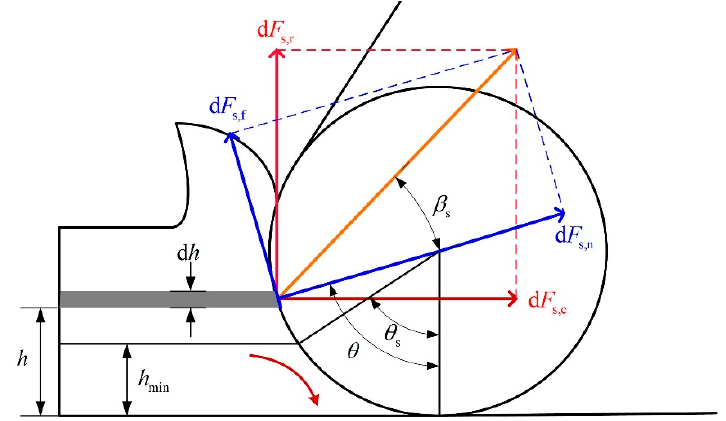
Figure 1. The distribution of cutting force under cutting edge radius size effect.